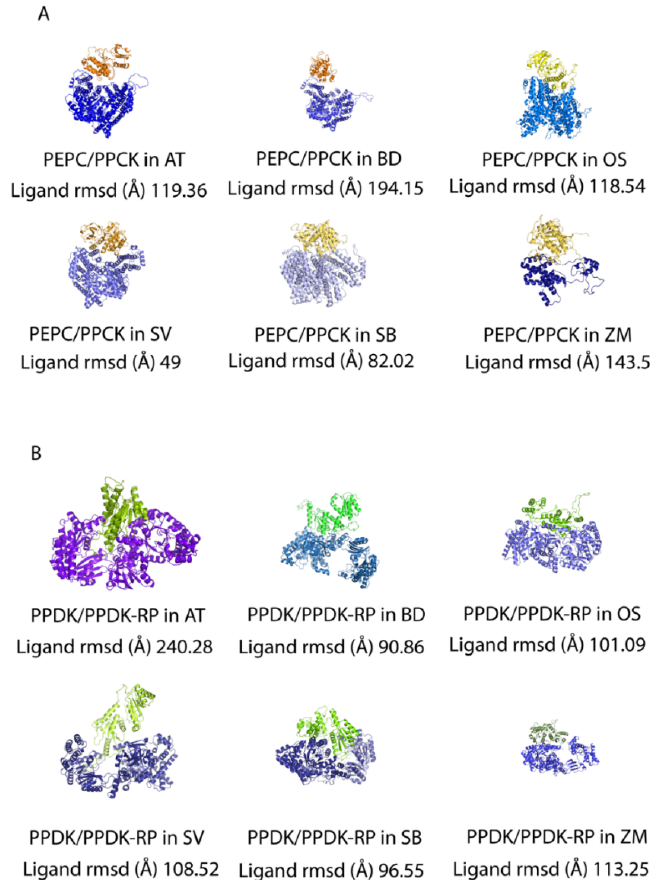
Figure 7. Protein–protein docking between interactive enzyme pairs. ( A ) Protein–protein docking between PEPC3 and PPCK2 in Arabidopsis thaliana , Brachypodium distachyon , Oryza sativa , Setaria viridis , Sorghum bicolor , and Zea mays . The affinity between the interaction of two proteins is illustrated by ligand RMSD values. ( B ) Protein–protein docking between PPDK and PPDK-RP1 in Arabidopsis thaliana , Brachypodium distachyon , Oryza sativa , Setaria viridis , Sorghum bicolor , and Zea mays . The affinity between the interaction of two proteins is demonstrated by ligand RMSD values as